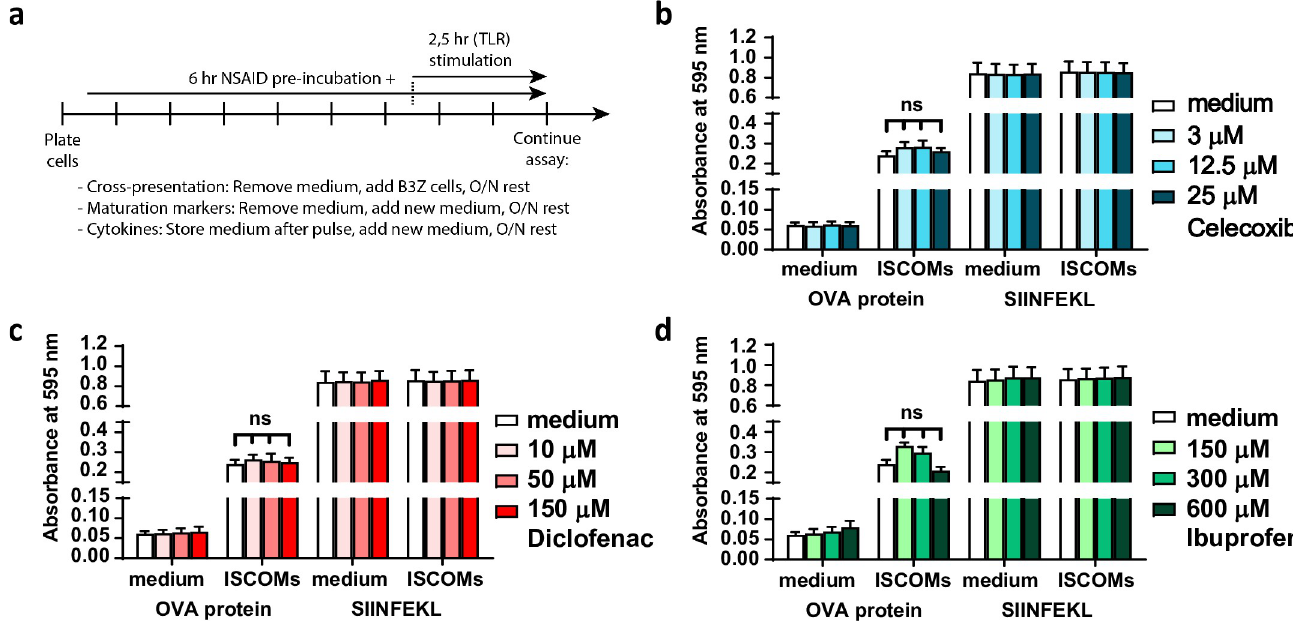
Fig 2. NSAIDs do not affect ISCOM induced cross-presentation. (a) Timeline shows the experimental setup for assessing cross-presentation, maturation markers and cytokine production by mBMDCs. (b-d) mBMDCs were first pretreated with NSAIDs for 6 hr, washed and subsequently treated with OVA protein and ISCOMs for 2.5 hr, and then co-cultured with B3Z T cells for 18 hr. As a positive control for viability and MHC-I levels, mBMDCs were pulsed with OVA peptide (SIINFEKL) 0.5 hr before coculture with B3Z T cells (n = 4). ISCOM induced cross-presentation of OVA protein and stable loading of